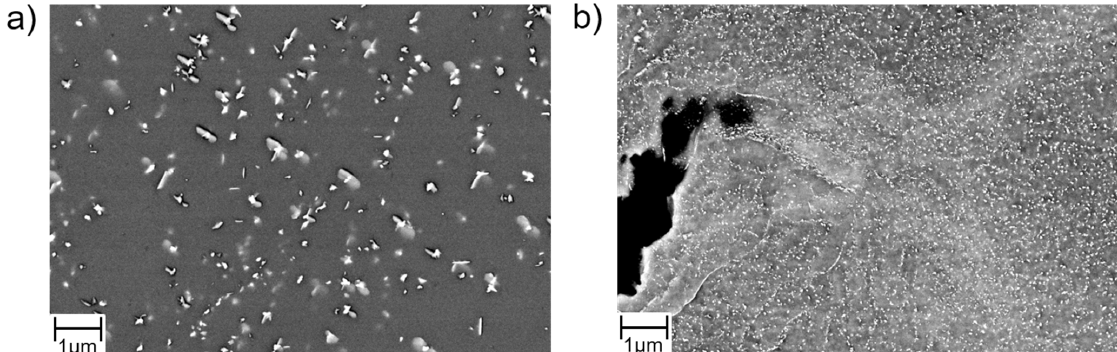
Figure 14. SEM images show a qualitative comparison of Laves phase particle density in ( a ) thermally loaded and ( b ) thermomechanically loaded (PA) Crofer ® 22H.